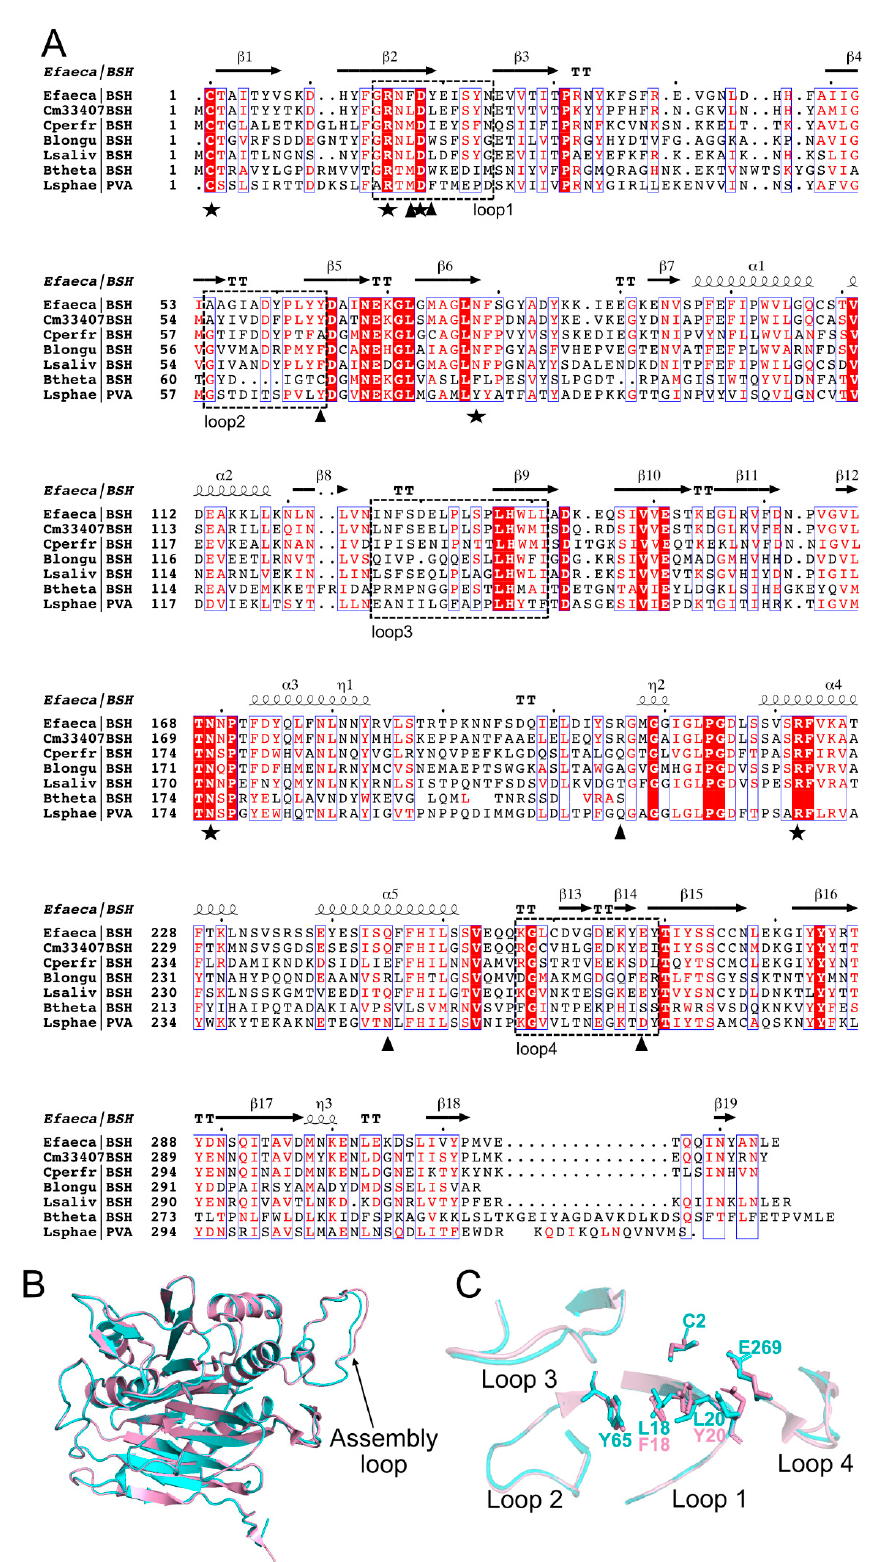
Figure 3. Alignment of the structure-based protein sequence of BSH from C. minuta DSM33407 and representative BSH and PVA members. ( A ) Full protein sequence alignment of 325 amino acids numbered. See Table S1 for accession numbers and references. Conserved residues are highlighted in red. Black stars indicate the amino acid residues that are conserved in the choloylglycine